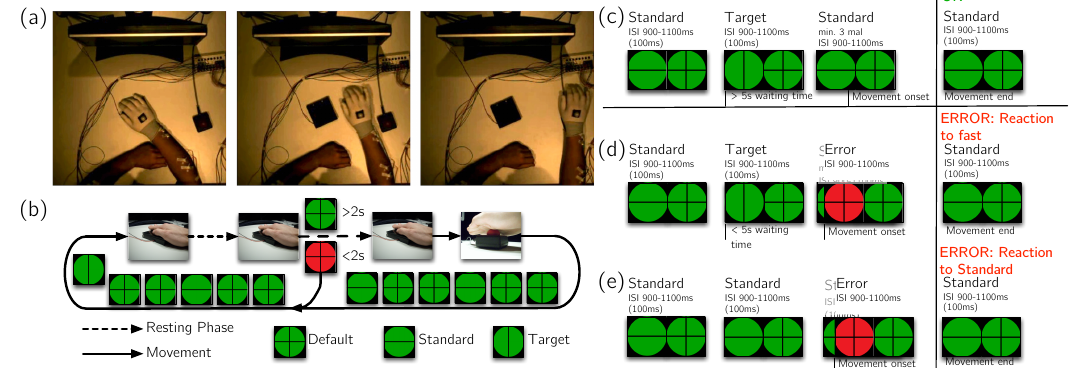
Figure 4. Illustration of the conducted experiments. ( a ) Three pictures of the setup, showing from left to right: the resting phase, the movement phase and the buzzer press; ( b ) Visualization of the paradigm; ( c ) Correctly performed movement; ( d , e ) Notification of incorrectly performed movements.